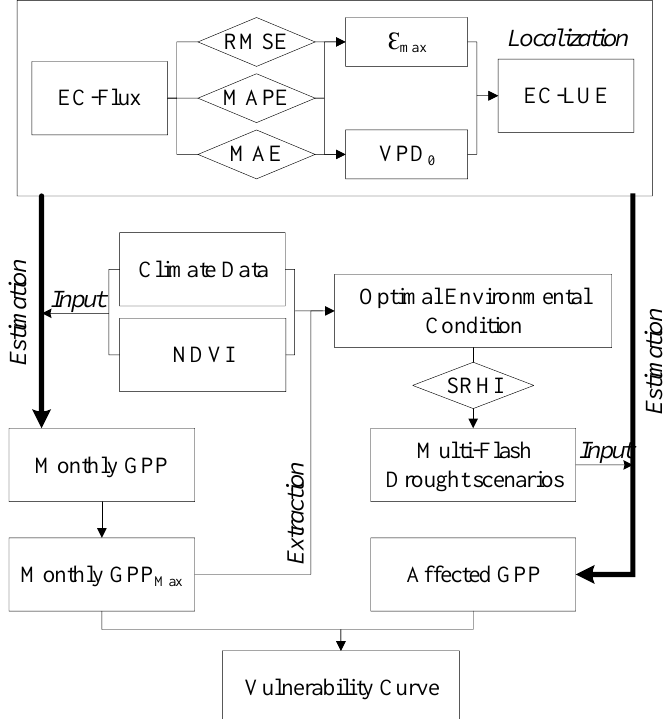
Figure 2. Study flowchart. RMSE: root mean square error; MAPE: mean absolute percentage error; MAE: mean absolute error. SRHI: standard relative humidity index; ε max : the maximum LUE; VPD 0 : the empirical coefficient of the water demand constraint equation; NDVI: normalized difference vegetation index.